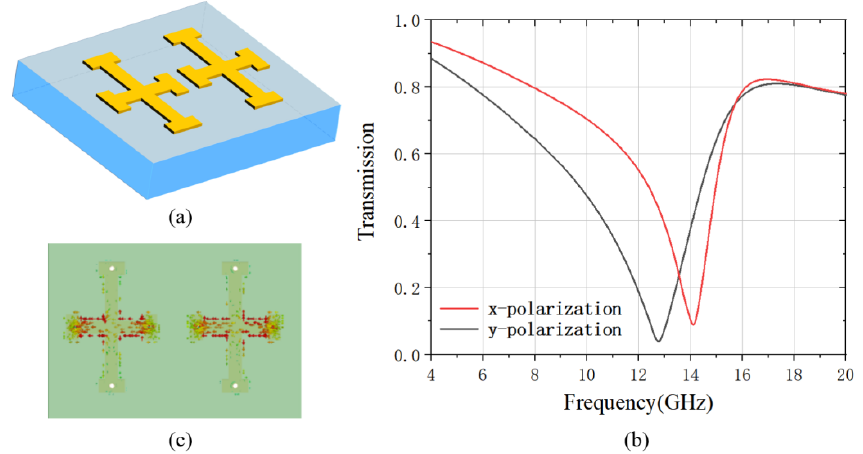
Figure 2. ( a ) the schematic of the double-cross unit cell; ( b ) the simulated x-polarized and y-polar- ized transmission of the double-cross metamaterial; ( c ) the surface current of the x-polarization dip at 14.1 GHz. 14.1